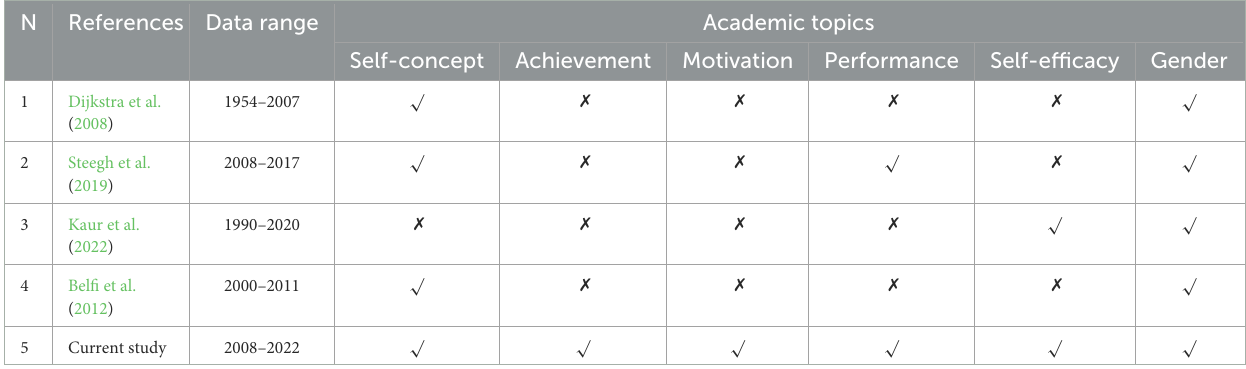
TABLE 1 A comparison between previous studies and the current